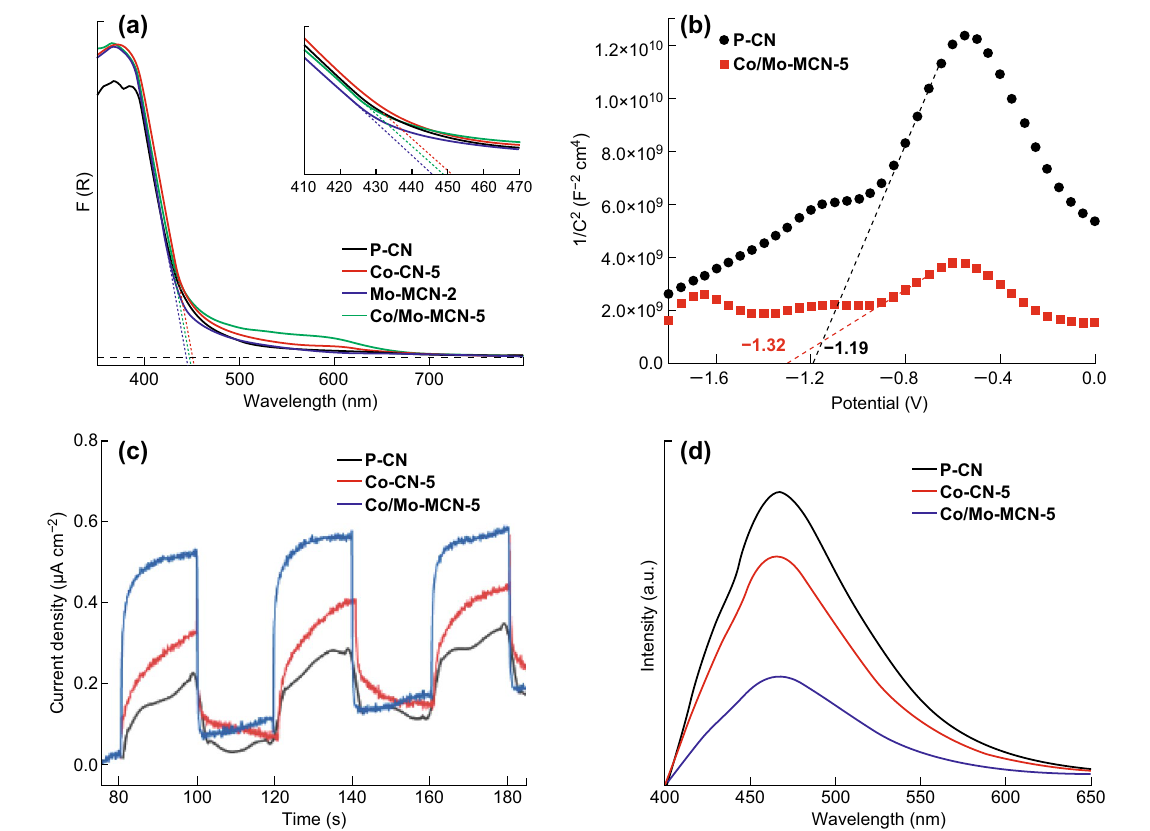
Fig. 7 a UV–Vis absorption spectra of P-CN, Co-CN-5, Mo-MCN-2, and Co/Mo-MCN-5, b Mott–Schottky plots of P-CN and Co/Mo-MCN-5, c transient photocurrent responses, and d photoluminescence spectra of P-CN, Co-CN-5, and